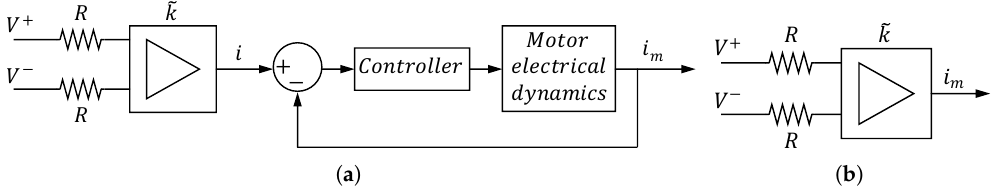
Figure 2. ( a ) Complete amplifier scheme. ( b ) Equivalent amplifier